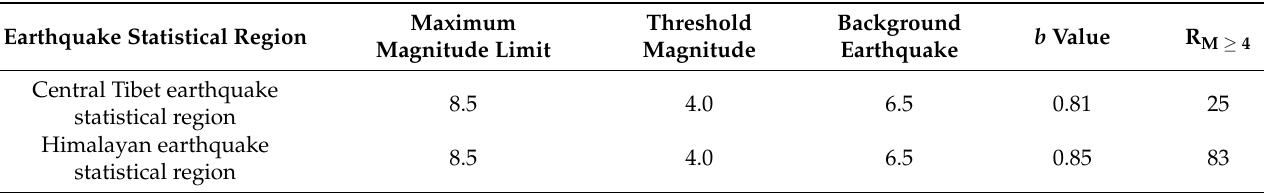
Table 2. Activity parameters of the earthquake statistical